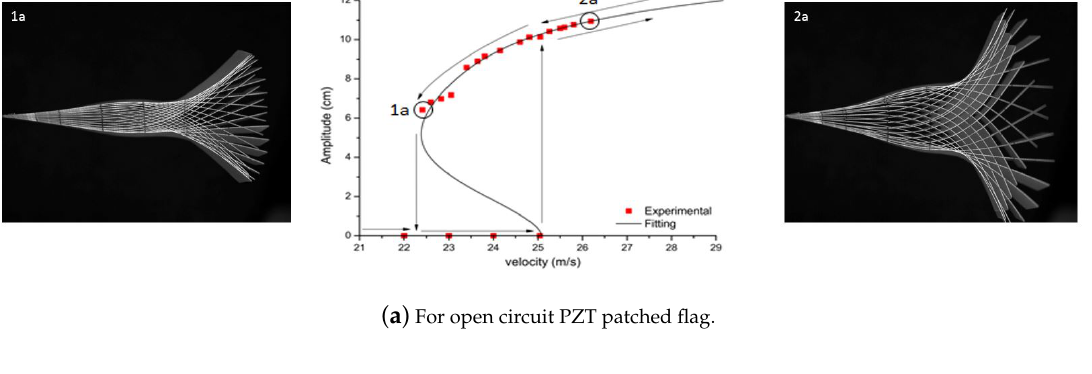
( a ) For open circuit PZT patched flag.